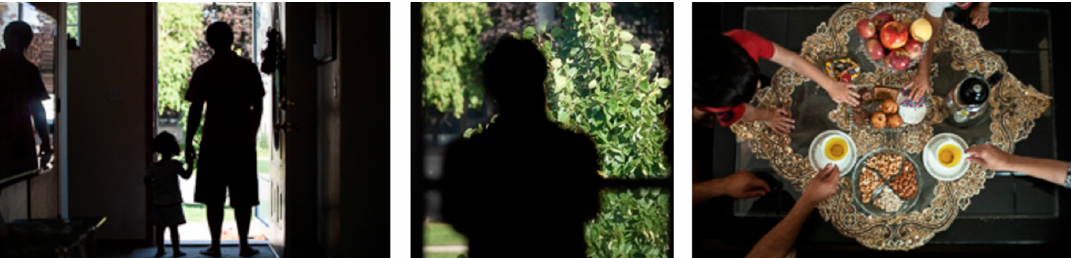
Figure 6. Jawad. Jawad* worked as an interpreter for the US military in his home country of Afghanistan. He was allowed to resettle in Wisconsin by the US government due to his service to this country’s armed forces. *Jawad’s name has been changed and his identity hidden out of respect for his family’s security.